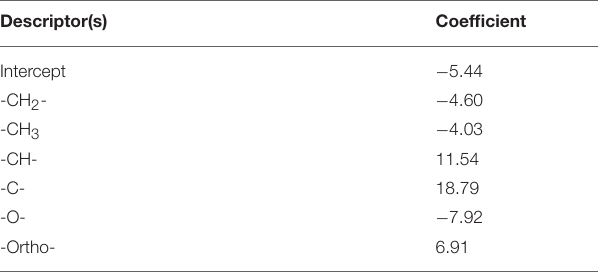
FIGURE 1 | T g prediction accuracy vs. experimental via QSPR method. TABLE 6 | Coefficients of the linear regression for T g prediction.